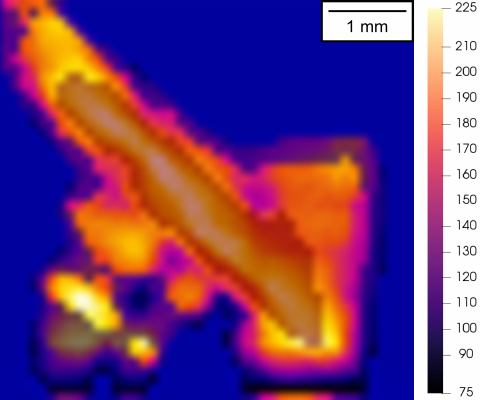
Figure 12. Thermogram of the 90 ◦ degree orientated specimen compressed at a high rate (i.e., 5100s − 1 ). The thermogram is segmented to a range of 75–225 ◦ C to highlight the heated regions of the localised deformation, where the macroscopic damage develops during the